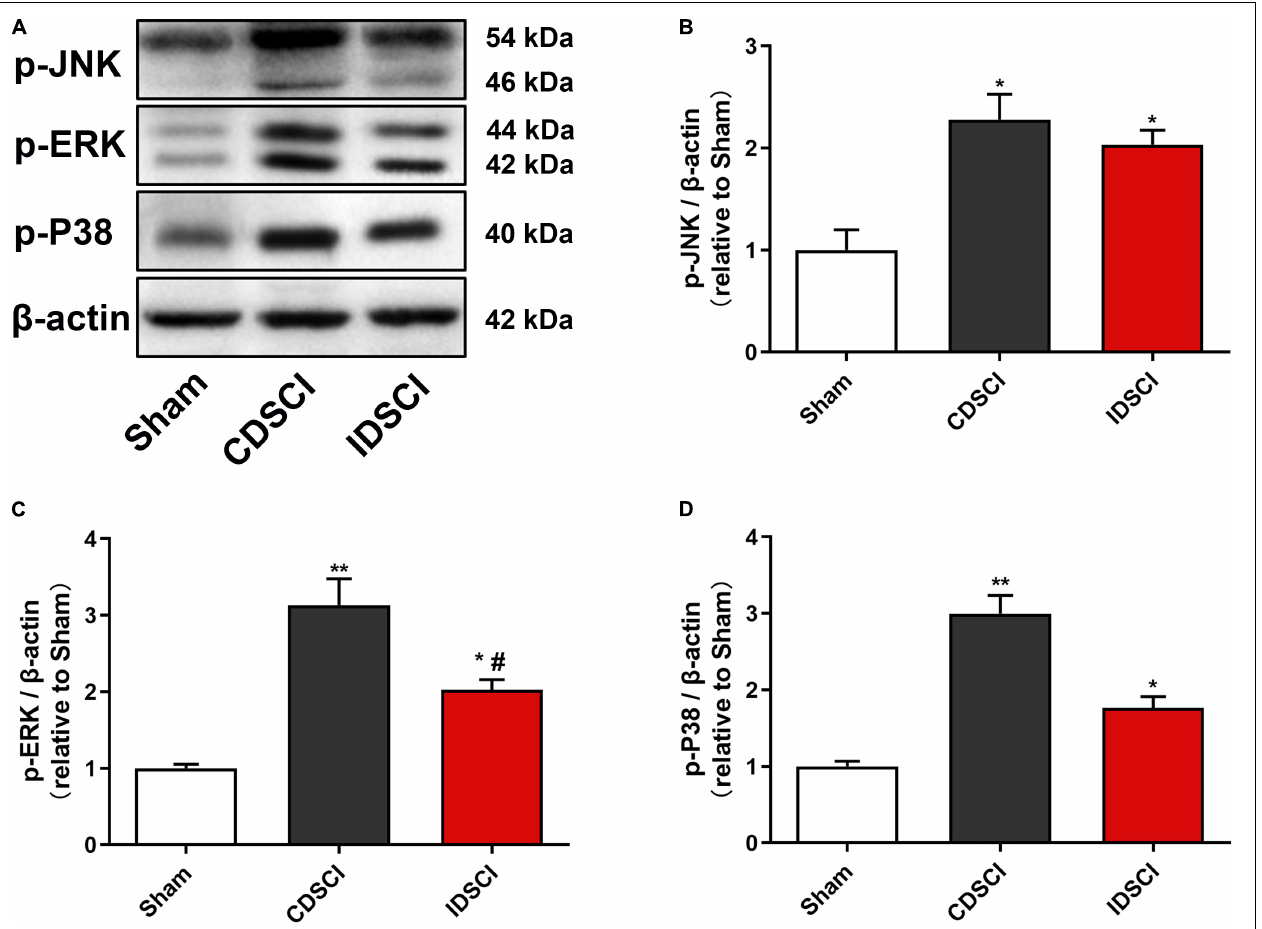
FIGURE 7 | Determination of the expression levels of MAPK signaling pathway-related proteins in the spinal cord tissues after DSCI. (A) The representative immunoblots of p-JNK, p-ERK, p-P38, and β -actin are listed. (B–D) Grayscale values of p-JNK, p-ERK, p-P38 were determined using ImageJ software based on the bands in the immunoblots ( n = 3). All values are expressed as means ± SD. * P < 0.05, ** P < 0.01, vs. the sham group; # P < 0.05, ## P < 0.01, vs. the CDSCI